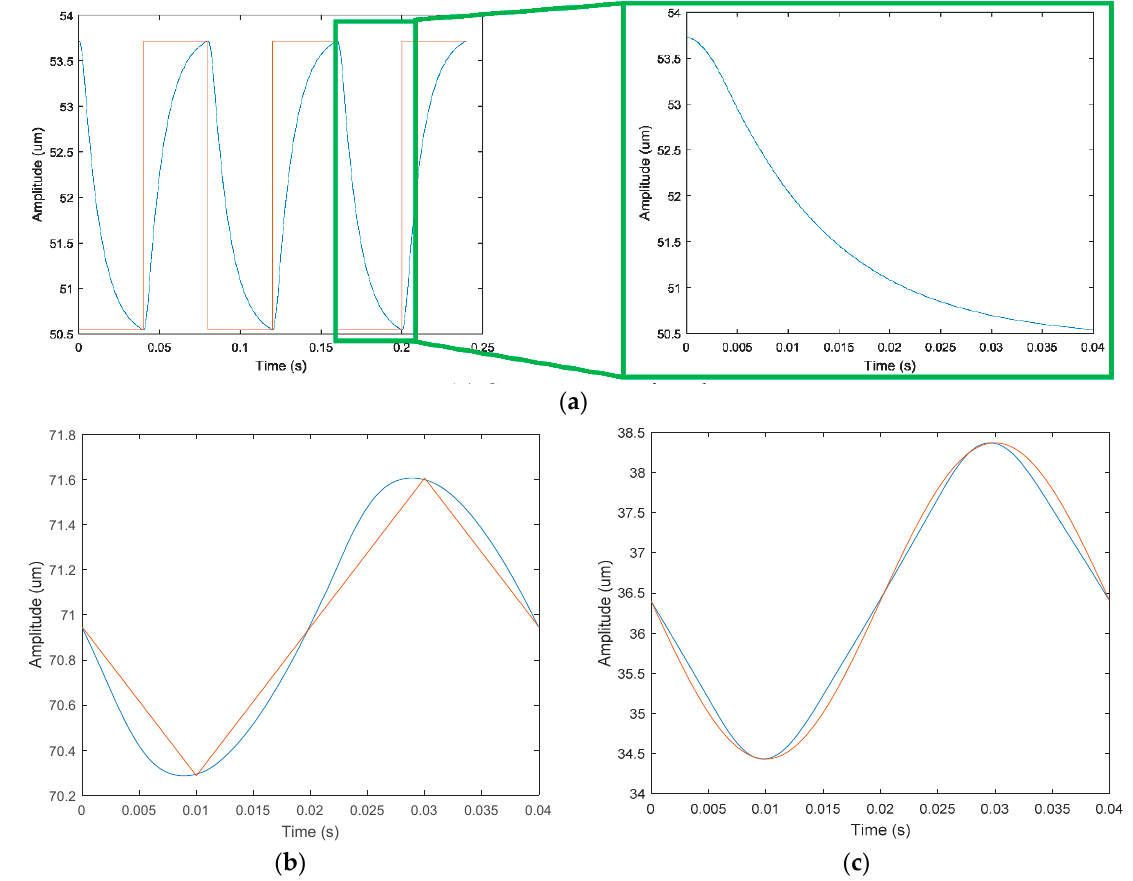
Figure 29. Response curve in z direction. ( a ) Square wave signal; ( b ) triangle wave signal; ( c ) sine wave signal.